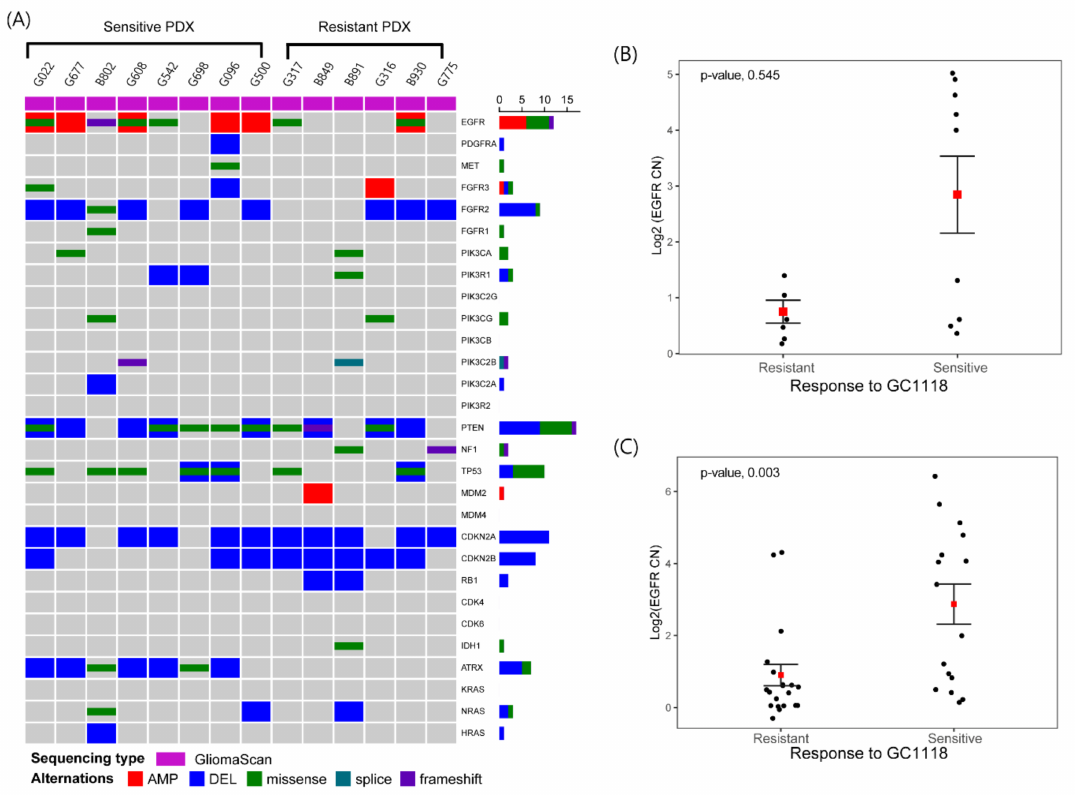
Figure 3. EGFR amplification as a potential biomarker to predict the e ffi cacy of GC1118 against GBM. ( A ) An oncoplot depicting major genomic alterations associated with the response to EGFR-targeting therapy; ( B ) comparison of EGFR copy number between GC1118-sensitive and -resistant PDX models (genomic data were derived from PDX models); ( C ) comparison of EGFR copy number between GC1118-sensitive and -resistant PDCs validated using high-throughput drug screening experiment (genomic data were derived from patient-derived tumor tissue). Mean (red point) and standard error (line range) values are